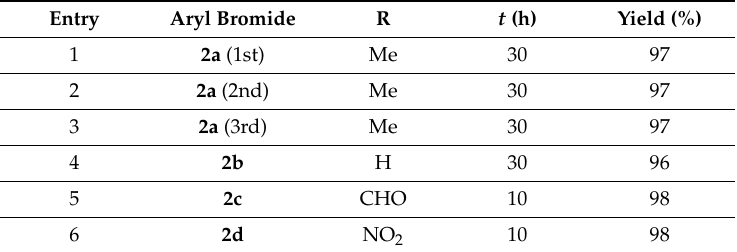
Table 1. Results of catalytic tests for the Suzuki–Miyaura coupling displayed in Scheme 1. Reprinted with permission from ref. [108]. Copyright 2015, Royal Society of Chemistry.